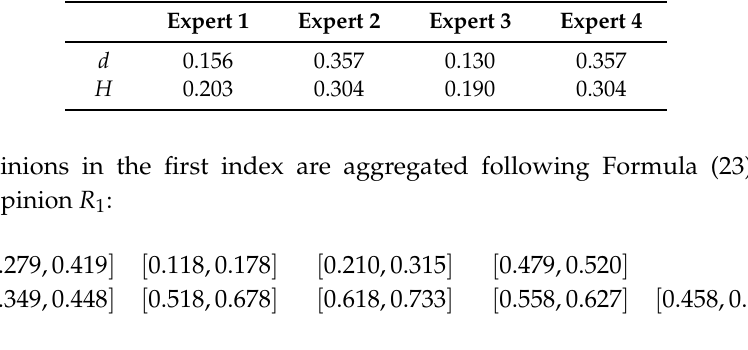
Table 3. Experts’ relative consistent degree and aggregation coefficient.